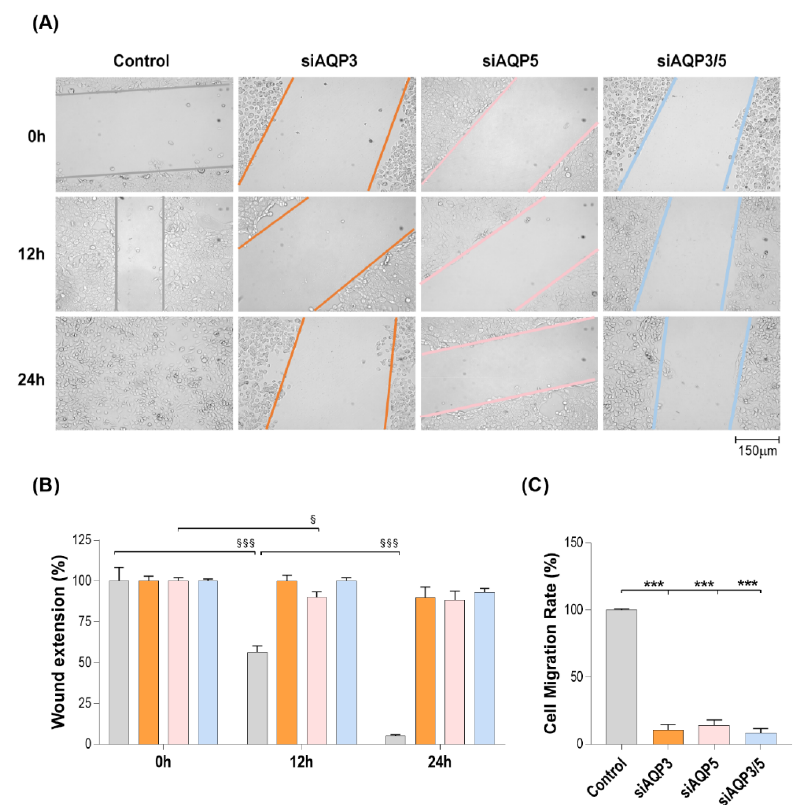
Figure 2. Effect of transient silencing of AQP3 and AQP5 in BxPC-3 migration. ( A ) Representative images of wound closure progression in control, AQP3-, AQP5-, and AQP3/5-silenced cells at 0, 12, and 24 h. ( B ) Wound extension progression in control, AQP3-, AQP5-, and AQP3/5-silenced cells at 0, 12, and 24 h past wound opening. ( C ) Cell migration rate of control, AQP3-, AQP5-, and AQP3/5-silenced cells. Results are expressed as mean ± SEM of three independent experiments. § p < 0.05; §§§ p < 0.001; both times after wound opening vs. initial measurement (0 h); *** p < 0.001, silenced vs. control cells.